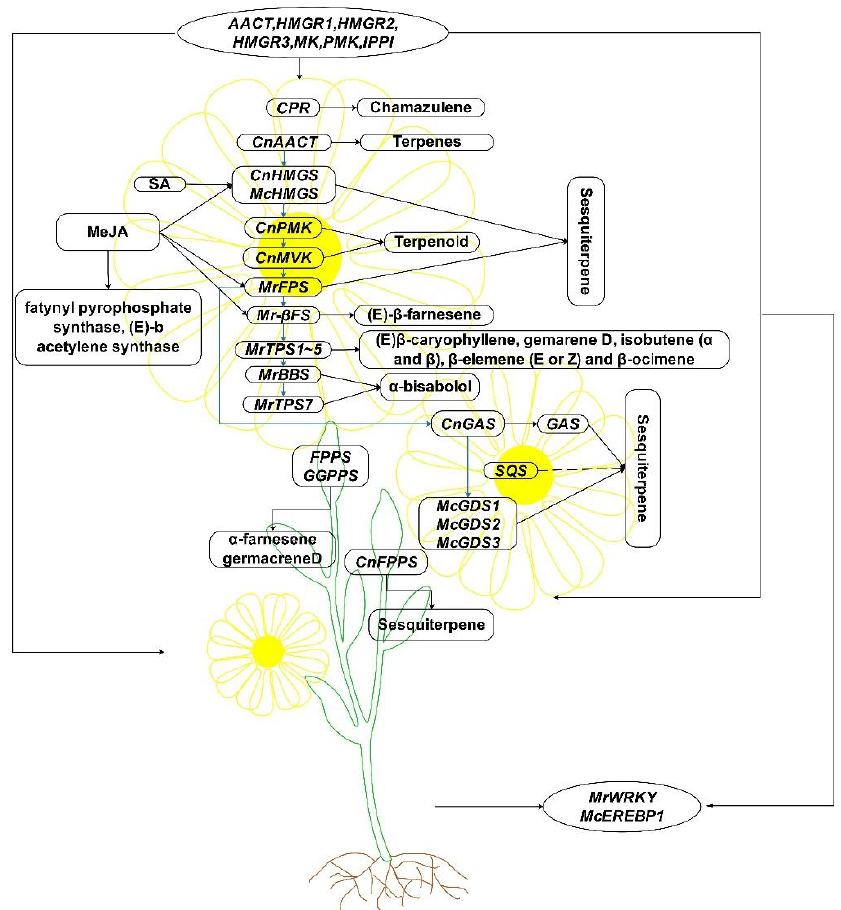
Figure 2. Secondary metabolic organs and products of M. chamomilla . Enzyme abbreviations: AACT (acetyl-CoA C-acetyltransferase); CAS (germacrene A synthase e); CPR (cytochrome P450 reductase); FPPS (farnesyl pyrophosphate synthase); GGPPS (geranylgeranyl diphosphate synthase); HMGR (3- hydroxy-3-methylglutaryl-CoA reductase); IPPI (isopentenyl diphosphate-isomerase); MeJA (methyl jasmonate); MK (MVA kinase); PMK (phospho-MVA kinase); SA (salicylic acid); SQS (squalene synthase). (The number after the gene is named in the original text, indicating that there are several homologous genes in the gene; for example, HMGR 1~3 indicates that there are 3 homologous genes in HMGR , named HMGR 1, HMGR 2, and HMGR